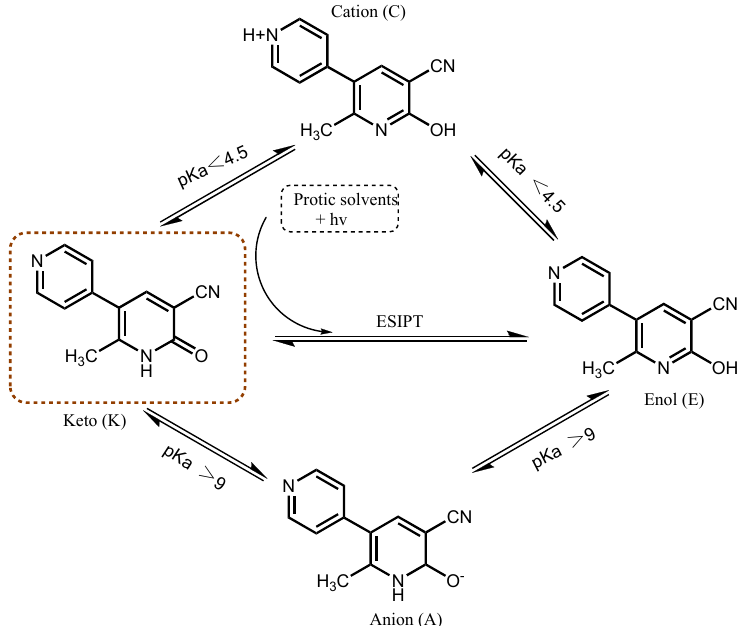
Figure 1. Schematic representation of the possible tautomeric equilibria between the different spe- cies of MLR. of